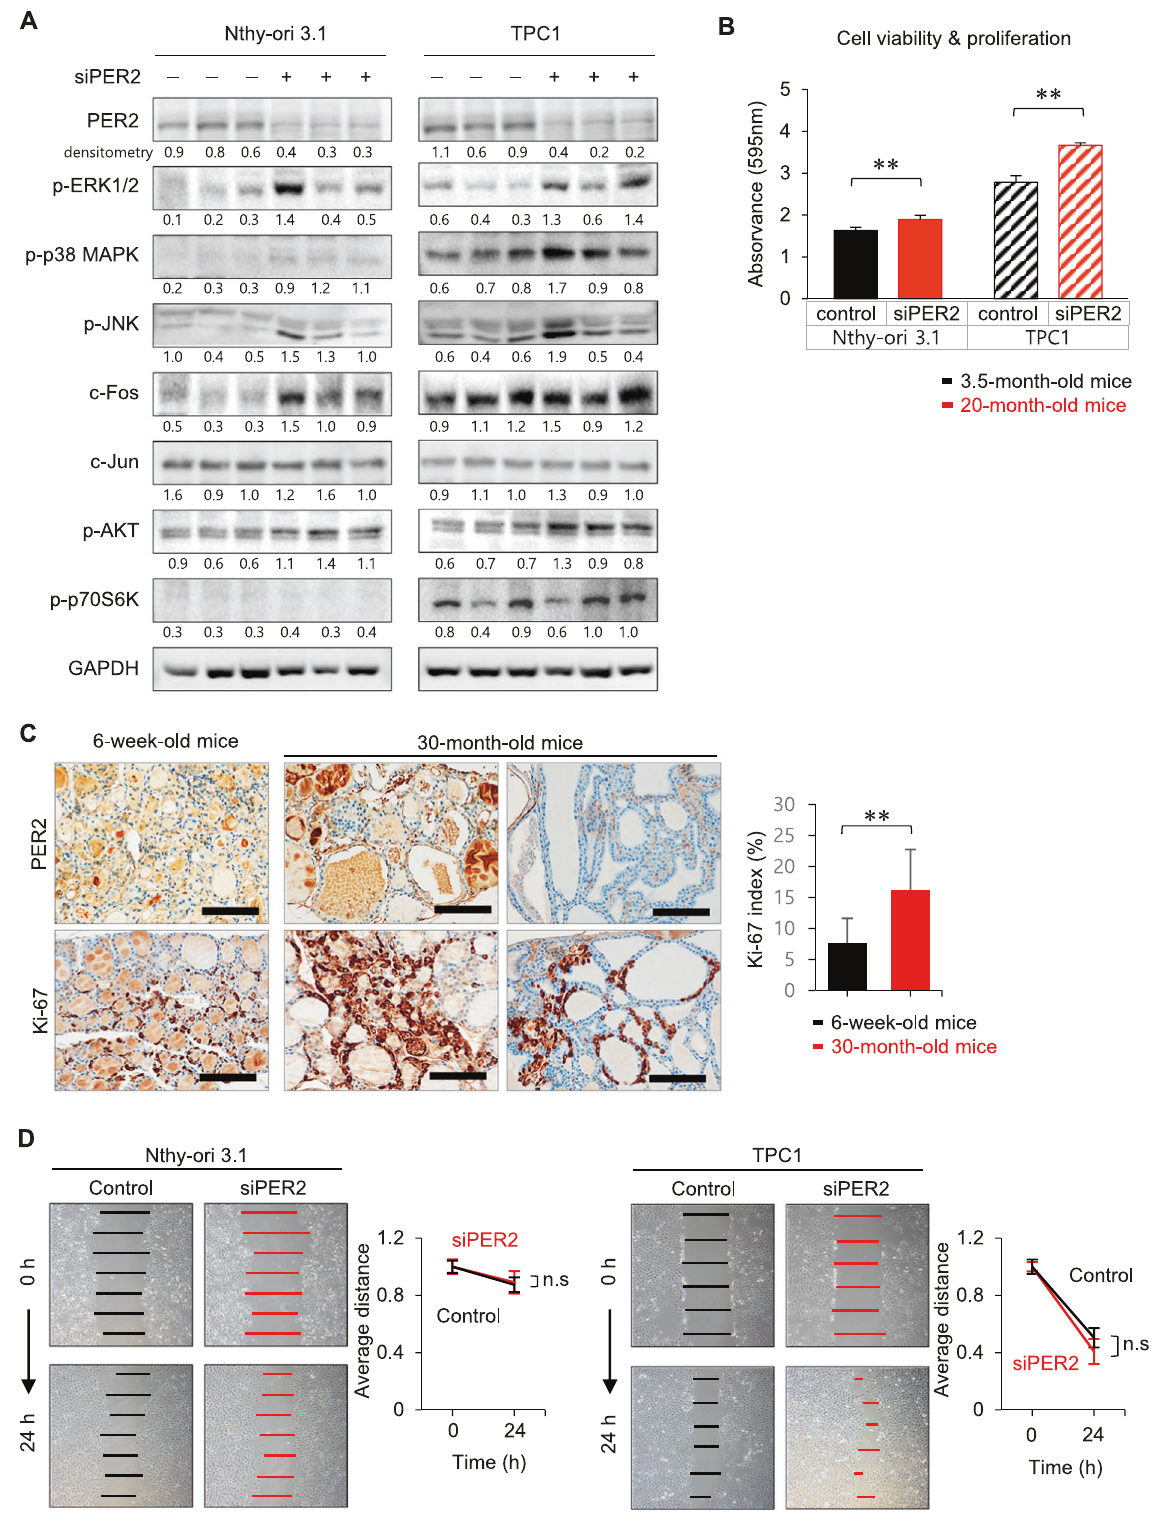
( p = 0.02). In addition, 20 of the samples were collected from PTC patients over 60 years of age (Table 2C). The age of patients with low PER2 expression (69 ± 6 years old) was higher than that of patients with high PER2 expression (65 ± 6 years old), but this relationship was not statistically signi fi cant ( p = 0.89, Fig. 6B,